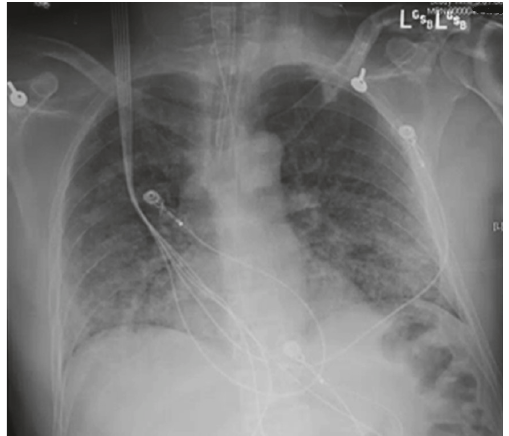
Figure 3: CXR showed diffuse bilateral infiltrates in a “snowstorm” pattern.